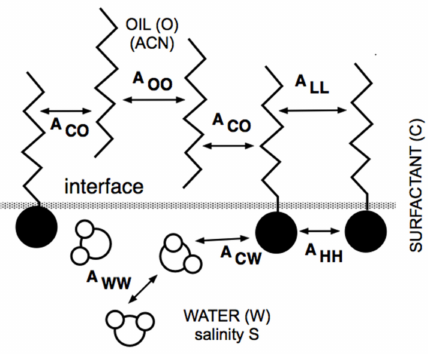
Figure 1. Interaction of surfactant, oil and water molecules close to interface according to Winsor’s scheme. The original model R = A CO /A CW was made more realistic by introducing the self- interactions between the surfactant, oil and water molecule as references, each in separated terms